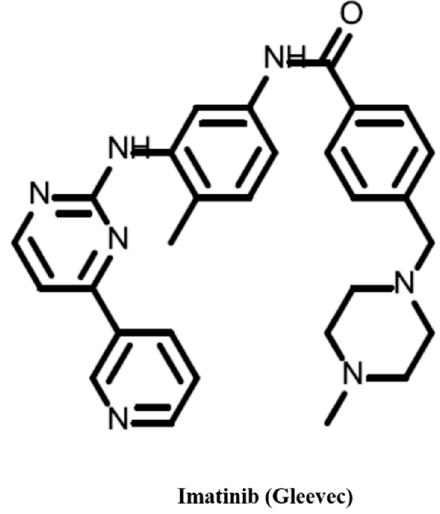
Figure 2. Imatinib (Gleevec) is the first FDA approved kinase inhibitor. Approved for the treatment of KIT+ GIST and Ph+ CML.